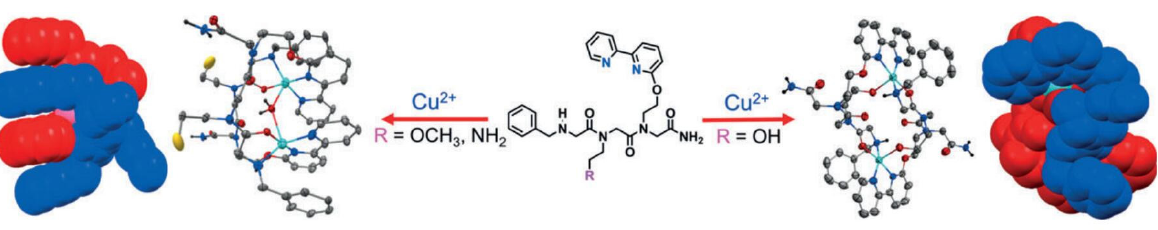
Figure 10. The self-assembly of two peptoid molecules with two Cu 2+ ions has led to the formation of a highly symmetric macrocycle and two aquabridged dimeric complexes that can be described, as dinuclear double-stranded peptoid helicates (Adapted from ref. [83]. Copyright 2018, Wiley-VCH Verlag GmbH & Co. KGaA, Weinheim).